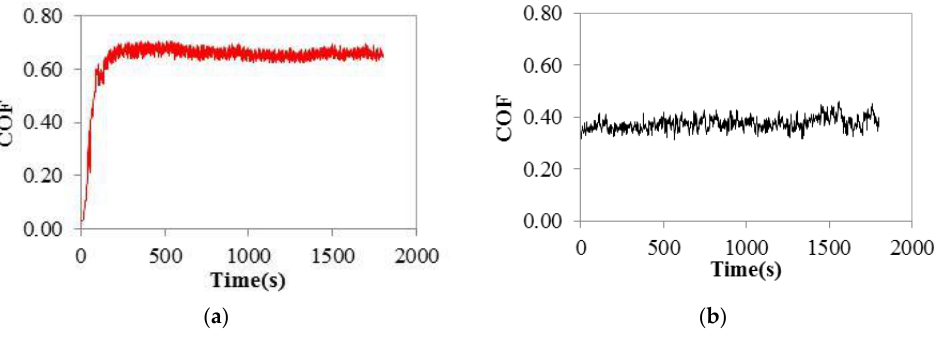
Figure 5. Evolution of COF with sliding time for LB-DED ( a ) NiTi and ( b ) Ti-6Al-4V alloys.